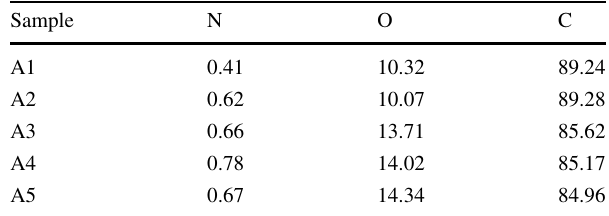
Table 4 Elemental contents of the samples surface measured by XPS (%) Sample